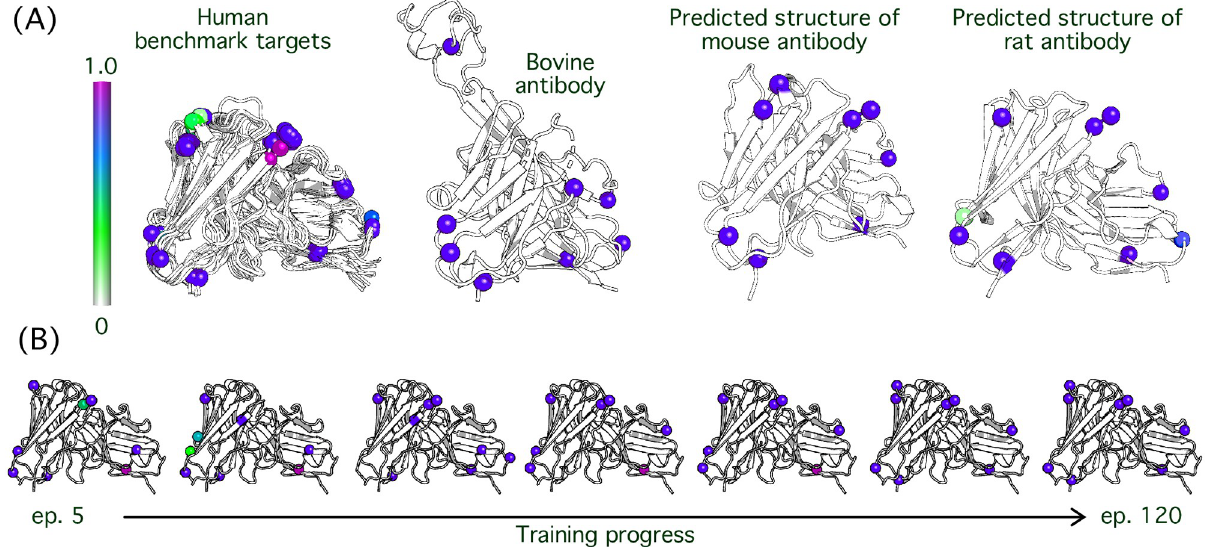
Fig 2. Identification of anchor residue positions from rotamer module attention. Rotamer module attention is interpreted to indicate positional significance in side-chain predictions. (A) An attention spectrum (left) ranging from white to magenta represents 0% to 100% attention, respectively. Human, bovine, mouse, and rat antibodies are shown. (B) The variation in attention level is shown with increasing training progress. The epochs represented are 5, 20, 40, 60, 80, 100, and 120.